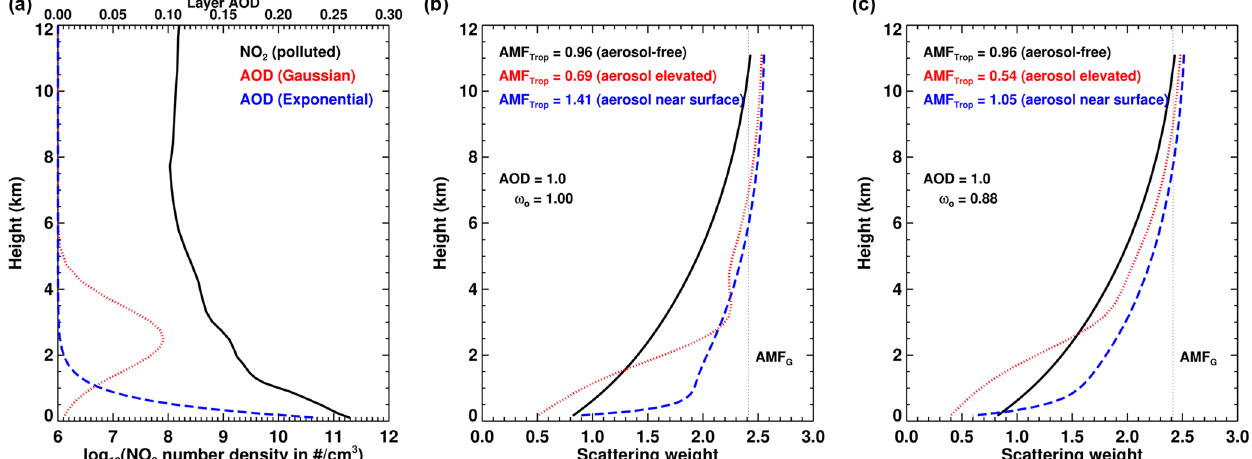
Figure 3. (a) Vertical profiles of tropospheric aerosols (layer aerosol optical depth (AOD), top scale) and the NO 2 number density (black line, bottom scale). (b) VLIDORT-calculated NO 2 Jacobians for aerosol-free atmosphere (black lines) and mixed with nonabsorbing (AOD = 1 . 0, ω 0 = 1 . 0) aerosols. The vertical dashed lines represent geometrical AMFs: AMF = sec ( SZA ) + sec ( VZA ) , where SZA and VZA are solar and view zenith angles. (c) Similar to the middle figure but for cases of absorbing aerosols (AOD = 1 . 0, ω 0 = 0 . 88).